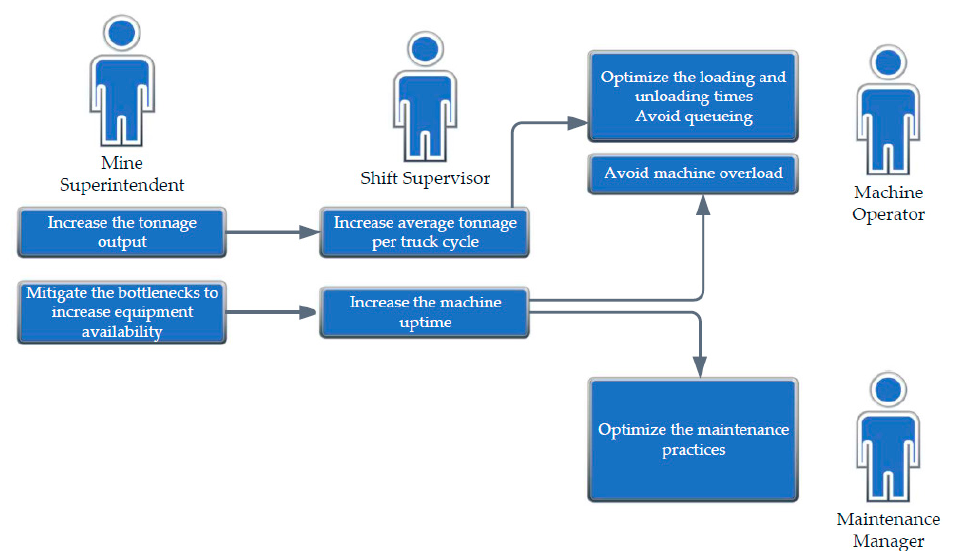
Figure 6. Exemplary chain of causality representing availability and performance optimisation in a mining organisation.